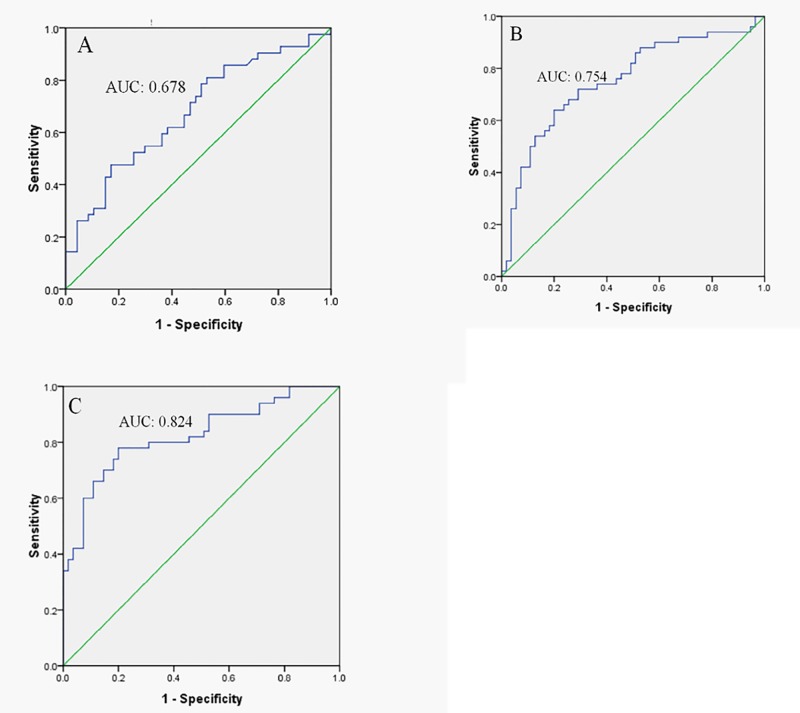
ROC curves of the independent factors based on retrospective study for predicting relapse.ROC curve of the IgDNA in differentiating post-treatment relapse with AUC 0.678 (A), ROC curve of IgDNA/IgHBeAg with AUC 0.754 (B) and IgDNA/IgHBeAg combined with consolidation duration with AUC 0.824 (C).